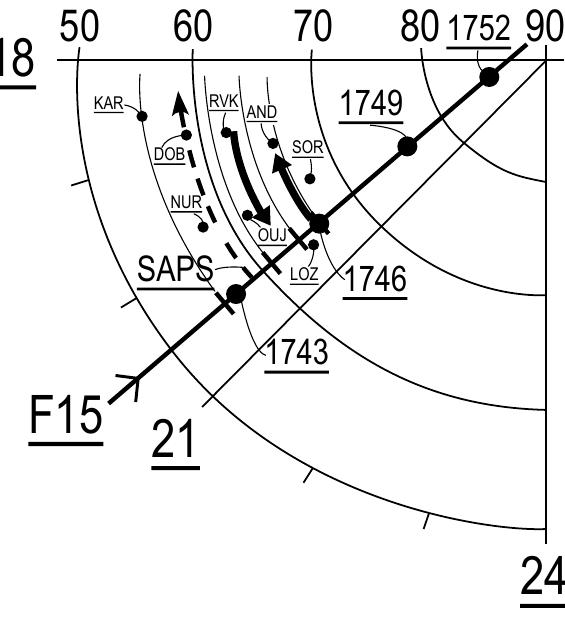
Fig. 11. Observation geometry of ground-satellite conjunction in the 19:00–21:00MLT sector with track of satellite DMSP F15 marked during the interval 17:43–17:52UT. The three latitudinal regimes of (i) subauroral polarization streams (SAPS; westward ion drift ( V w ) > 0.5kms − 1 within ∼ 58–62 ◦ MLAT), (ii) central plasma sheet precipitation and the eastward electrojet (EEJ) cur- rent within 62–64 ◦ MLAT, and (iii) auroral oval (AO) arcs within 64–66.5 ◦ MLAT and the westward electrojet (WEJ) centered at ∼ 66 ◦ MLAT have been marked along the track and in the MLT sec- tor of the magnetometer stations. The coordinate system is MLT versus MLAT. The locations of eight stations of ground magnetome- ters in the IMAGE chain are marked by solid dots. Solid curved lines mark the centers of the westward (WEJ) and eastward (EEJ) electrojet activities as estimated from the ground magnetograms and the satellite observations of cross-track ion drift. The center of the westward-directed ion drift at subauroral latitudes (SAPS) which is marked by the dashed curved arrow is inferred from the satellite